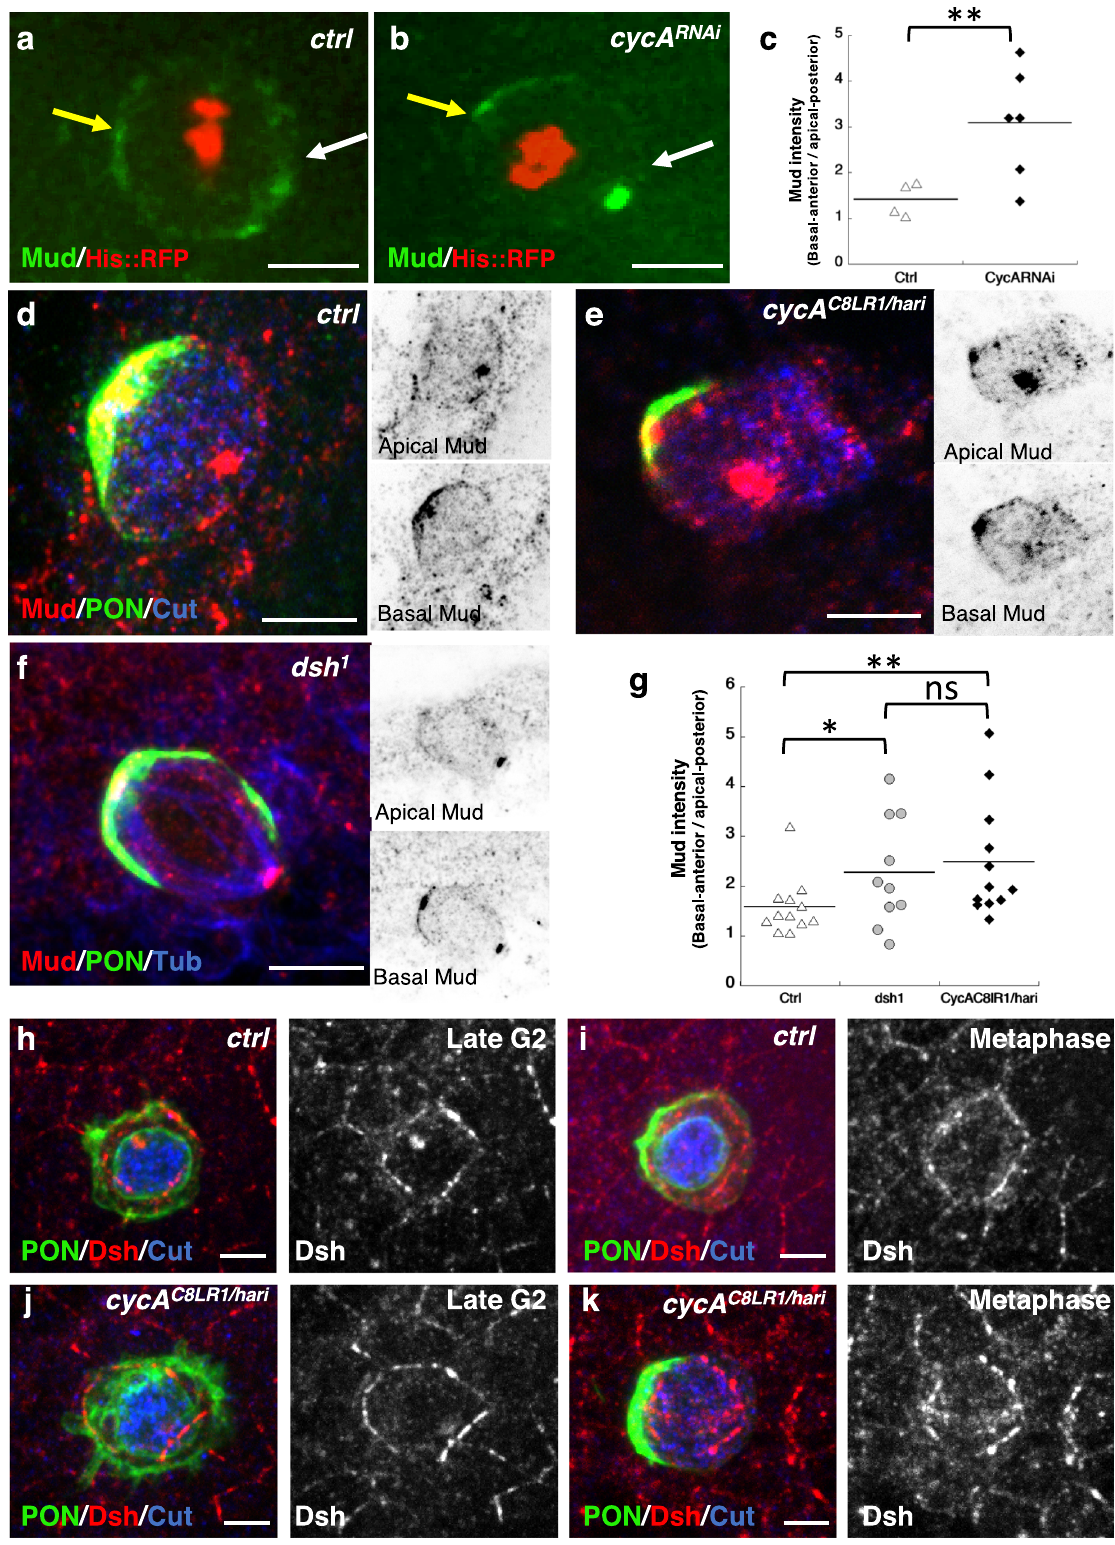
Methods Genomic and genetic engineering . CycA::eGFP is a CRISPR:Cas9 Drosophila melanogaster strain made by InDroso Functional Genomics (Rennes, France). The eGFP sequence was inserted at the C-terminus of the CycA sequence using the gRNA target sequence 5 ′ CGACTTCG/ATCAGCTCTGTGAGG3 ′ . A selection marker lies just before the STOP codon of the eGFP, which when removed leaves a NATURE COMMUNICATIONS| (2022) 13:2723